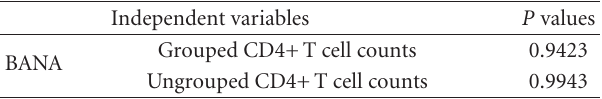
Table 5: Association between BANA with grouped and ungrouped CD4+T cell counts adjusted for oral